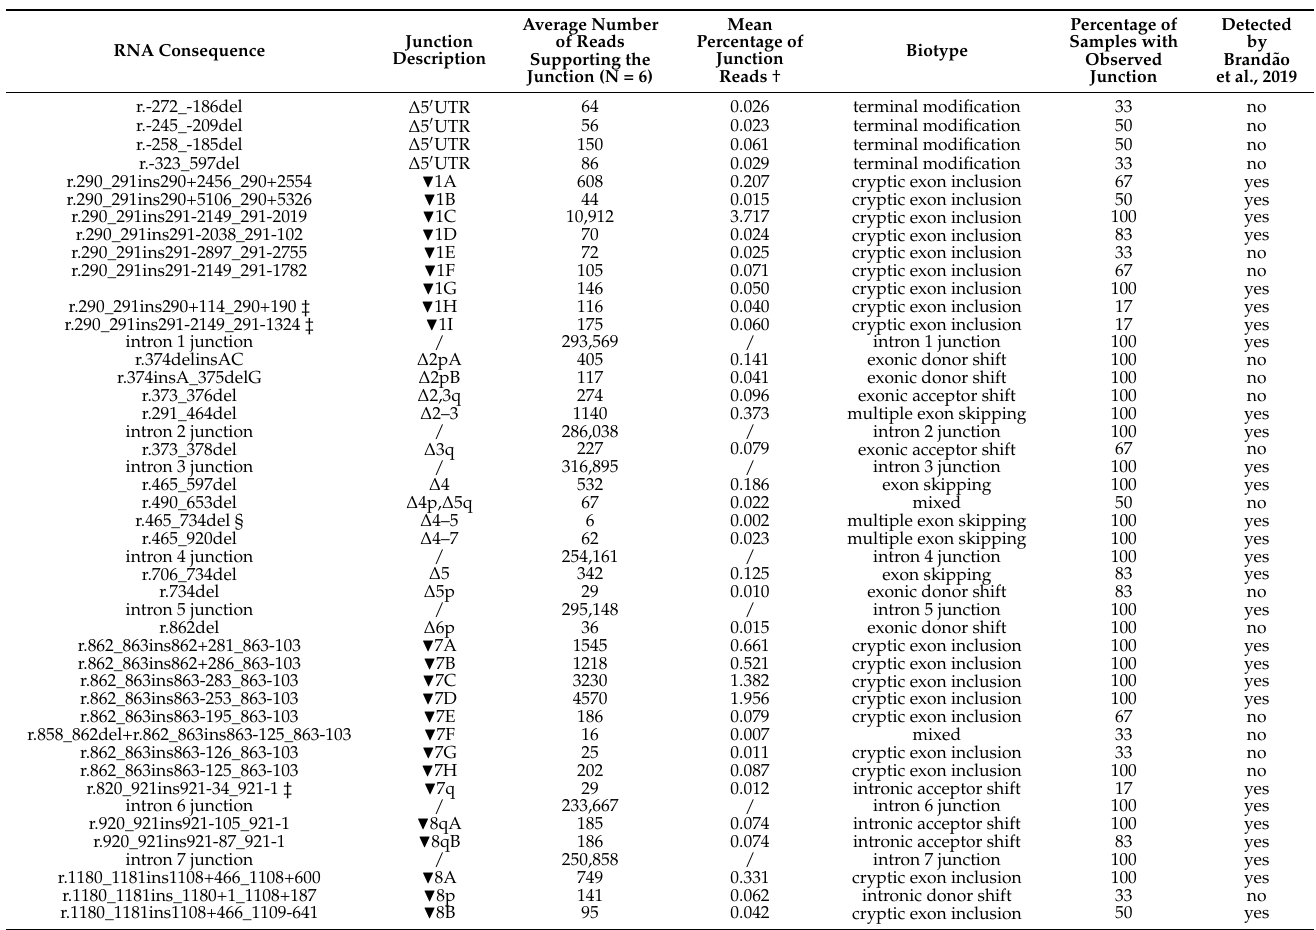
Figure 2. Schematic representation of major STK11 and NBN alternative splicing events. Only splicing events with expression higher than 1% are shown in the image. Table 1. Splicing events of STK11 gene detected by new RNAseq approach from control samples in comparison with data published by Brand ã o et al., 2019